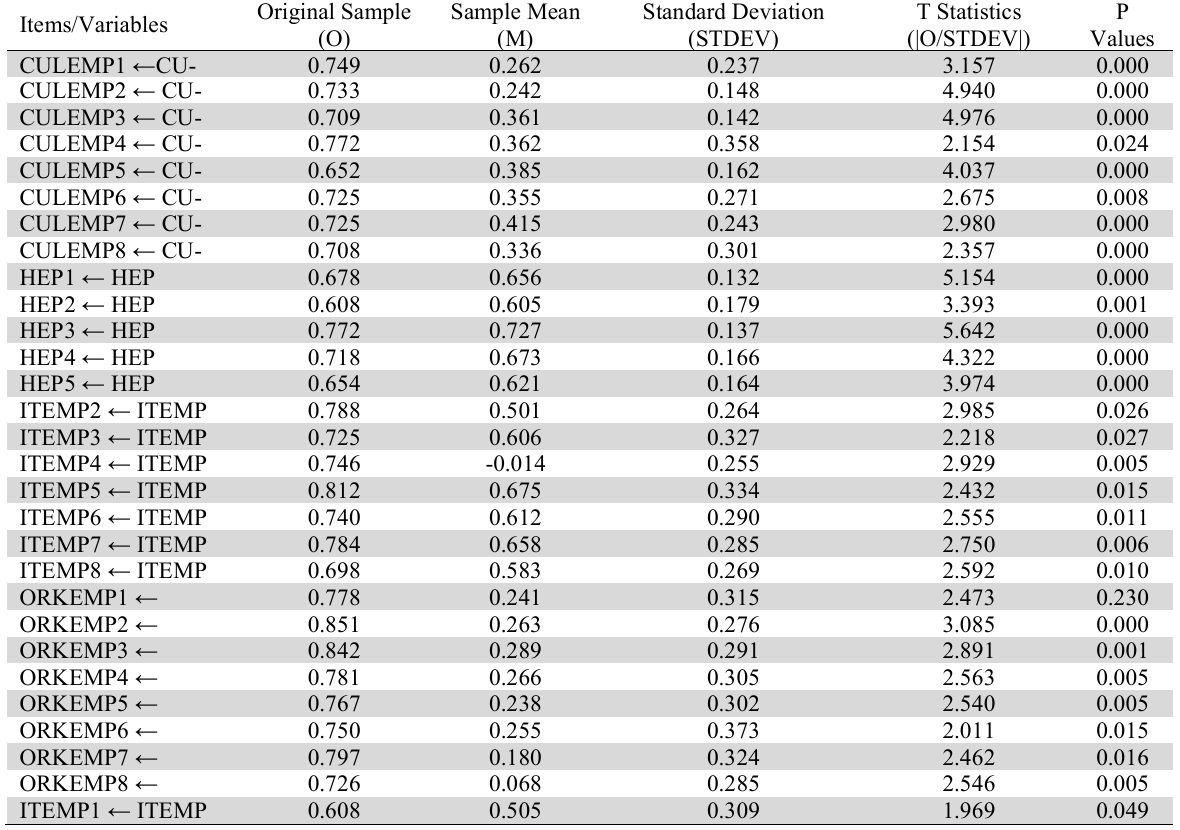
Factor loadings, sample Mean, Standard Deviation and P value for the Factor loadings Items/Variables